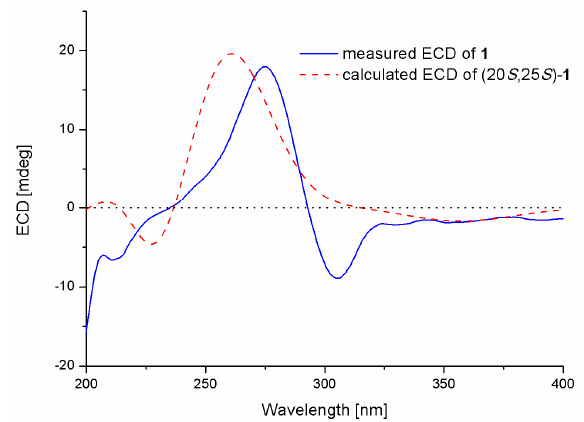
Figure 2. COSY (heavy blue lines) and selected HMBC (red arrows) correlations for 1 and/or 2 .